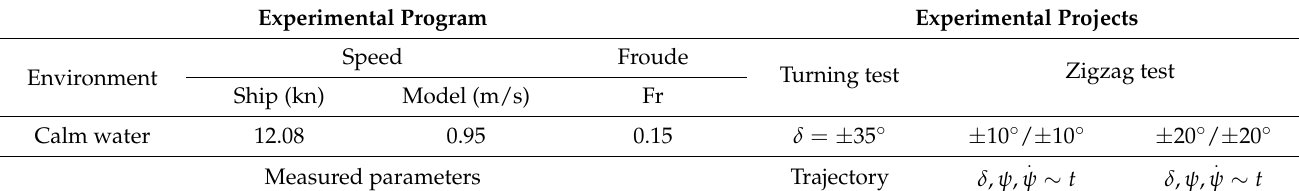
Table 4. Experimental programs and